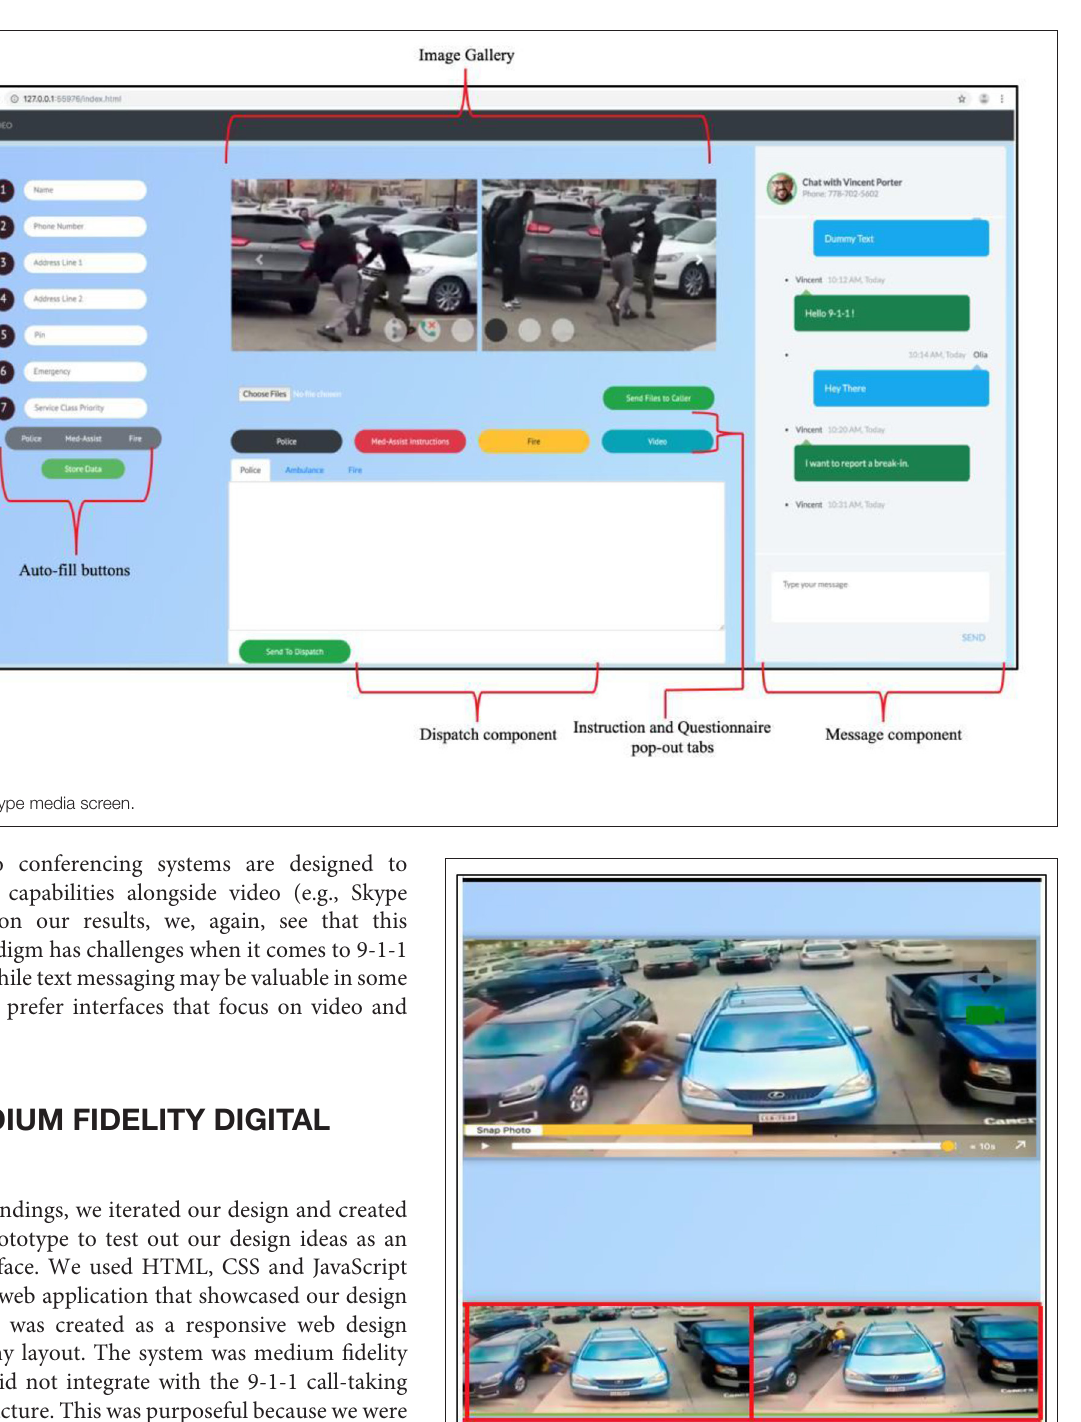
FIGURE 6 | Video stream (top) and selected clips